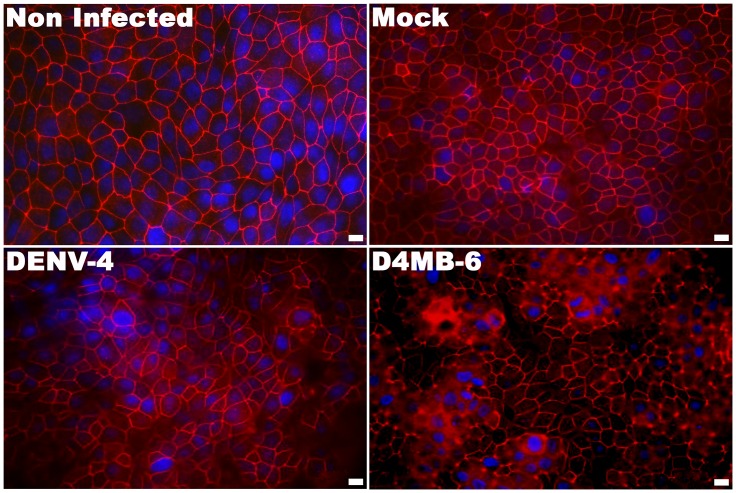
Immunostaining for ZO-1 in MBEC monolayer cultured on the inserts at 10 h p.i.ZO-1 (in red) displayed the expected continuous membrane lining fluorescence pattern along the cell margins of each endothelial cell. At 10 h p.i. with DENV-4 or after mock treatment this fluorescence distribution did not change. By contrast, at 10 h p.i. MBEC infected with D4MB-6 showed slight changes in morphology (some cell detached) and ZO-1 redistribution from margin to cytoplasm, a finding correlated with the initial decrease in TEER values and dextran blue pass through the membrane. Bar = 20 μm.